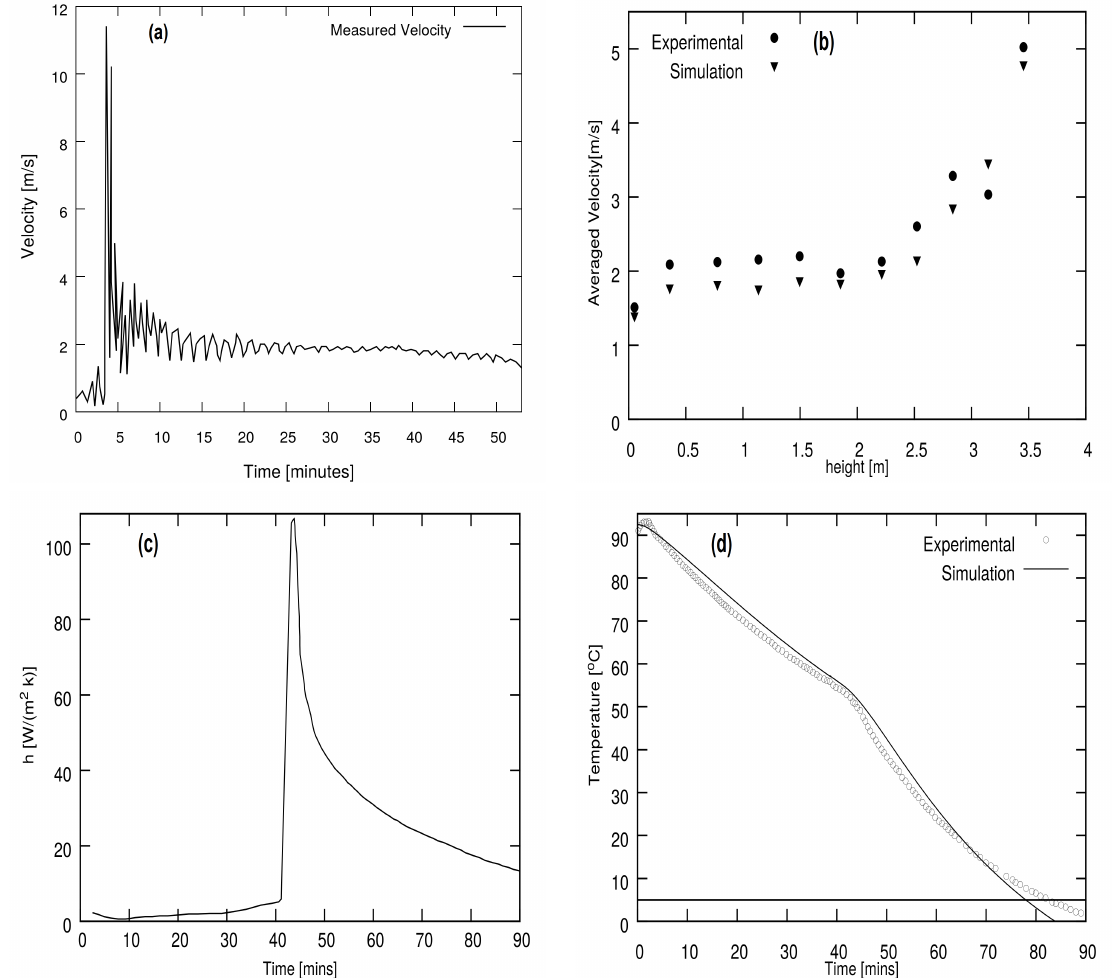
Figure 5. Data in ( a ) represents the measured velocity profile inside chiller spiral, the values of the velocity were measured from the upper tier to the lower tier (as shown in Figure 6a) across the chilled spiral. Data in ( b ) represents the average-velocity at each tier compared with the measured velocity at each tier. Data in ( c ) represents the heat transfer coefficient at the surface of a representative Cornish pasty obtained in ambient and chilled side. Data in ( d ) presents the measured and simulated temperature profiles at the core of pasty across whole cooling time in ambient and chilled